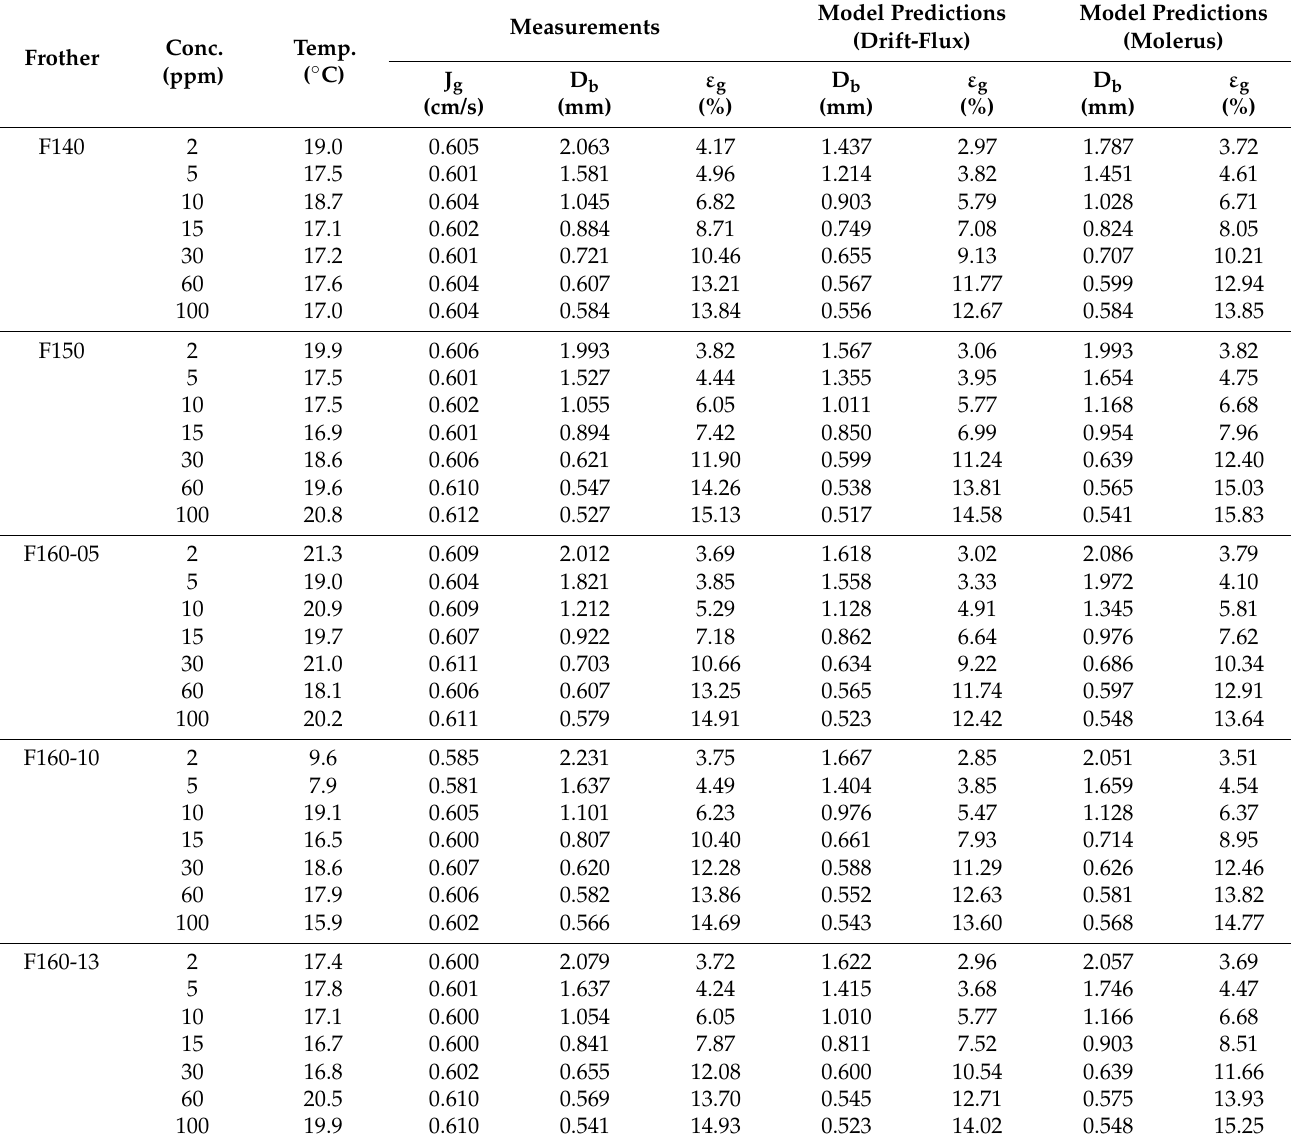
Table 2. Measured and model predicted values of gas dispersion variables obtained in the characteri- zation of frother effects on